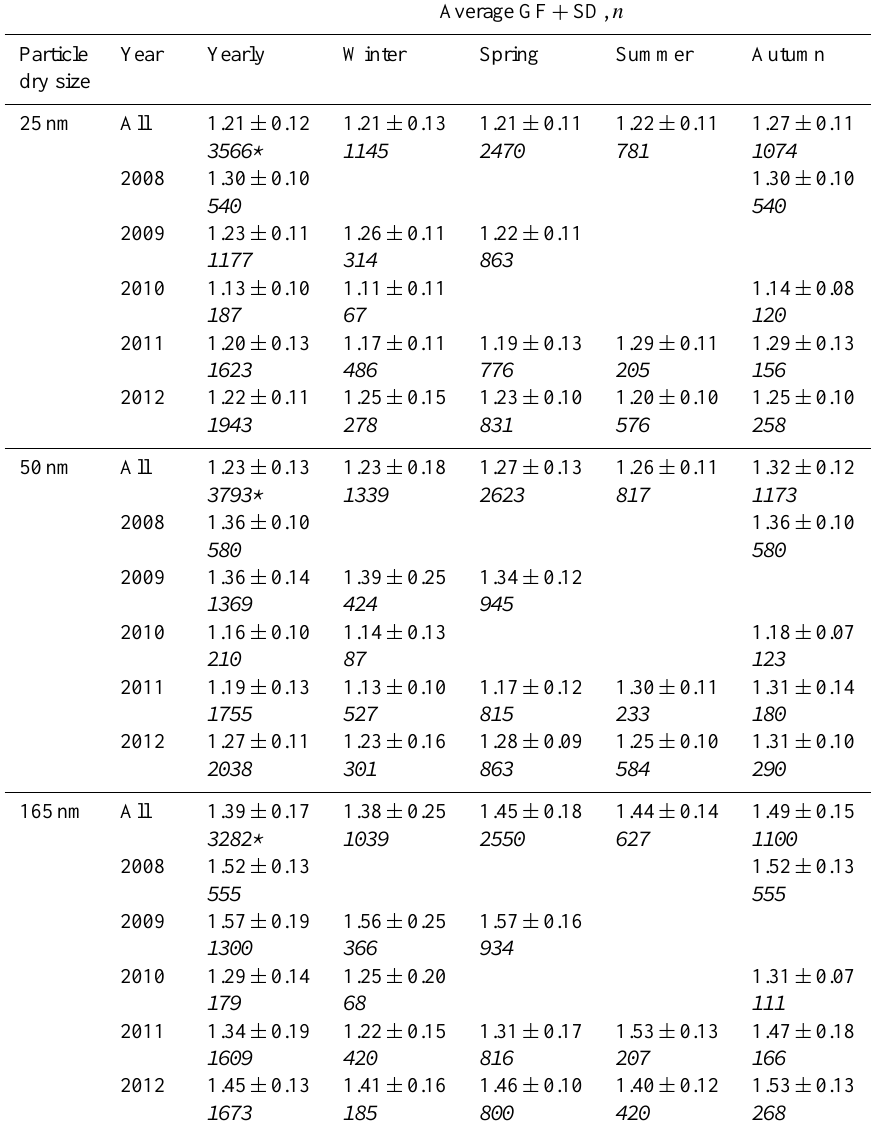
Table 1. Yearly and seasonal average hygroscopic growth factors (GFs) at RH90, including standard deviations (SD) and the number of scans ( n ) in each category of